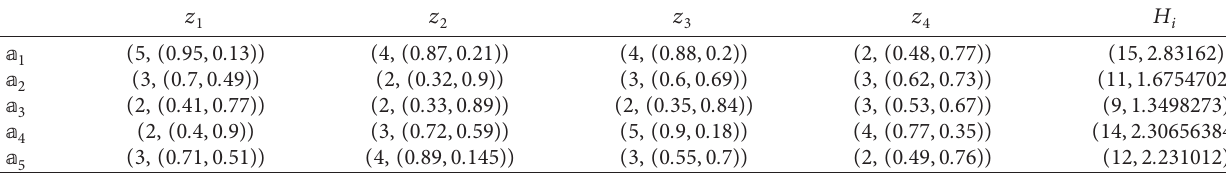
S in Section 5.1. f